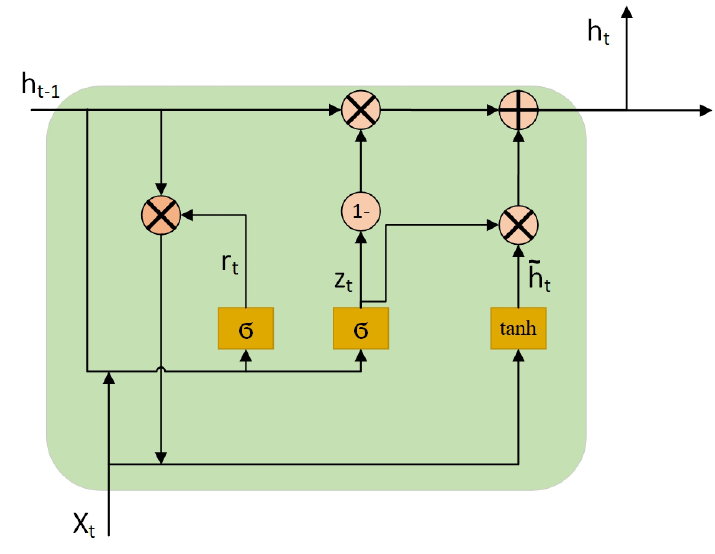
Figure 7. Structure of